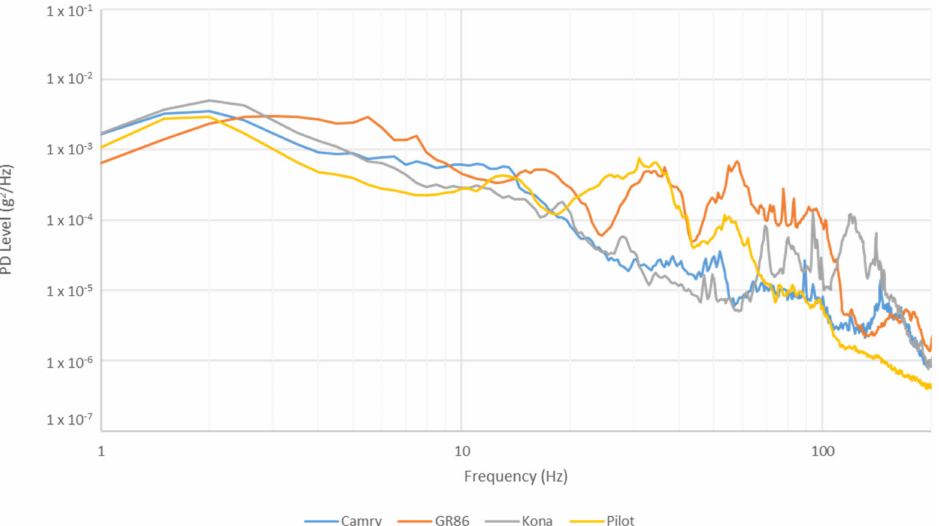
Figure 6. Overall PSD plots of four vehicles in vertical direction.